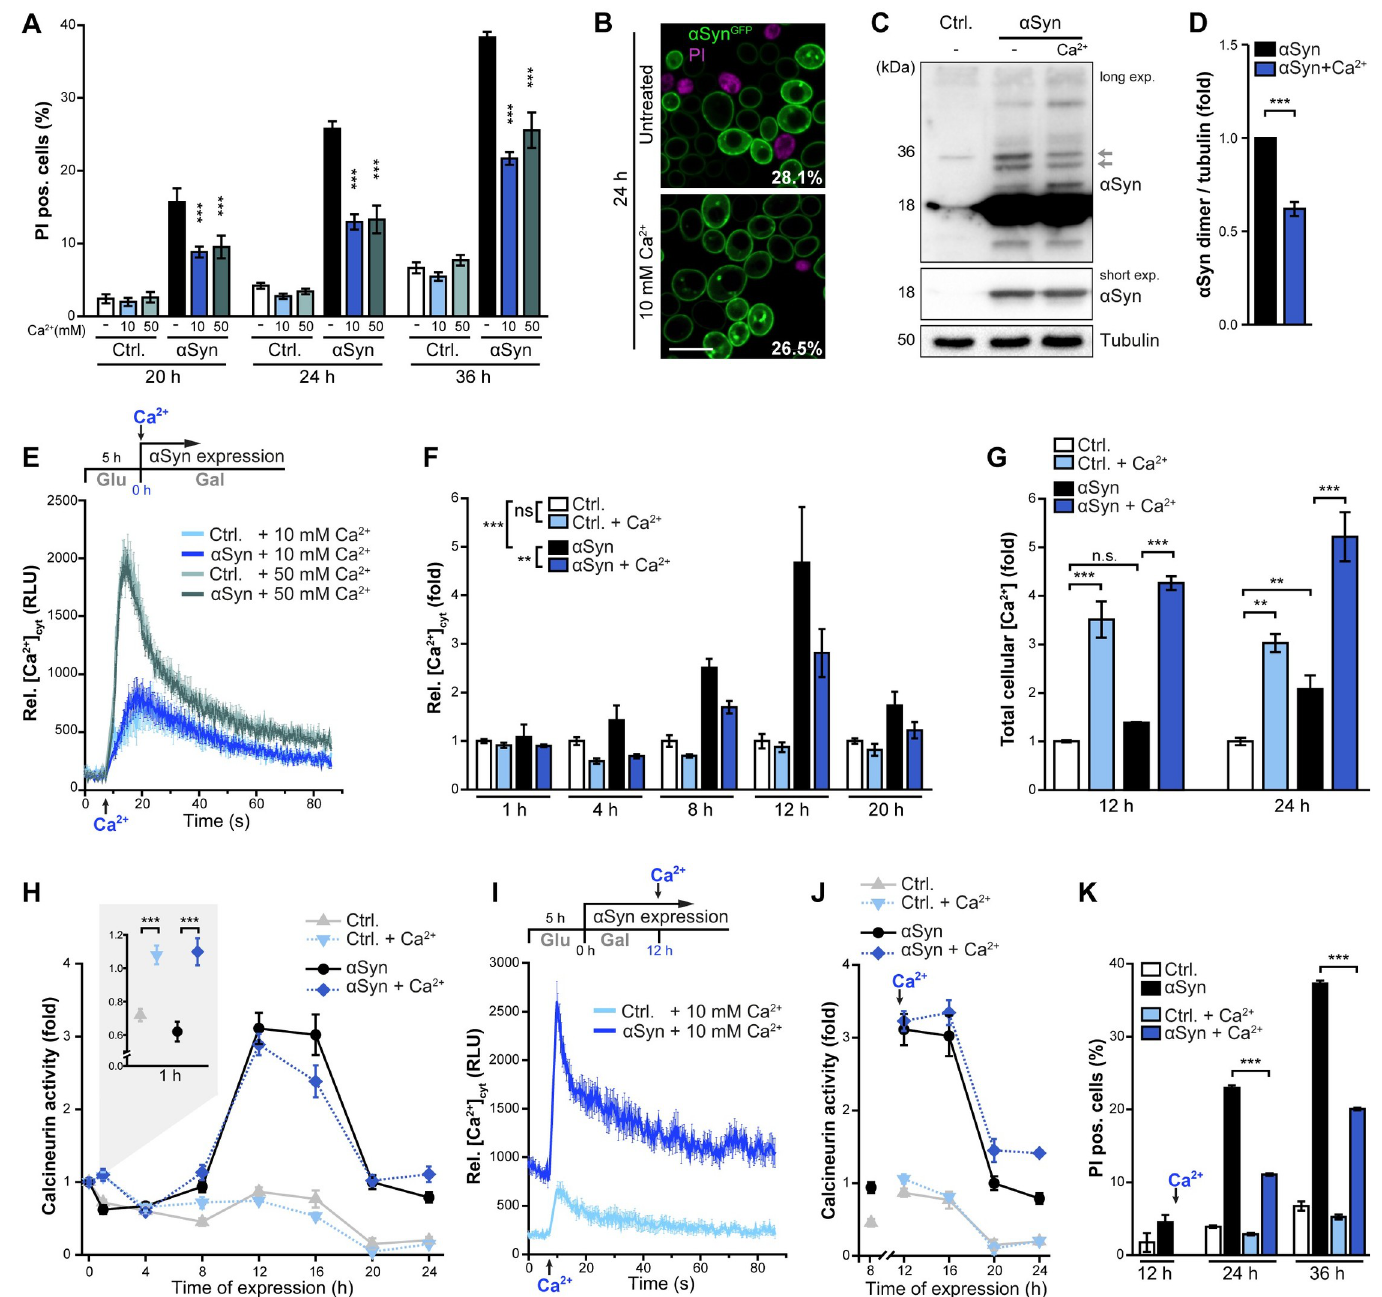
Fig 2. An external Ca 2+ pulse enforces organellar ion storage and mitigates the α Syn-driven rise in cytosolic Ca 2+ . ( A ) Flow cytometric quantification of cell death via propidium iodide (PI) staining of cells expressing α Syn for indicated time points or harboring the vector control (Ctrl.). Cells were supplemented with additional 10 mM and 50 mM CaCl 2 at the time point of shift to galactose or left untreated. Means ± s.e.m; n = 8. ( B ) Confocal micrographs of cells expressing α Syn GFP for 24 h counterstained with PI to visualize dead cells. Cells were supplemented or not with 10 mM Ca 2+ at the time point of shift to galactose media. Scale bar represents 5 μ m. Values indicate mean percentages of cells with α Syn GFP aggregates, with the following s.e.m.: Untreated : 28.1% ± 1.5% (in total 395 cells were evaluated); 10 mM Ca 2+ : 26.5% ± 1.8% (in total 643 cells were evaluated); n > 4. ( C-D ) Representative semi-native immunoblots of protein extracts of cells grown on media with and without additional 10 mM Ca 2+ for 36 h (C) and corresponding densitometric quantification (D) of dimeric α Syn species (as indicated by arrows in (C)). Blots were probed with antibodies directed against α Syn and tubulin as loading control, and the combined signal of the dimeric α Syn species was normalized to tubulin. Means ± s.e.m; n = 10. ( E ) Measurement of cytosolic Ca 2+ levels in cells equipped with a luminescence-based aequorin reporter construct. After monitoring the basal cytosolic Ca 2+ levels, Ca 2+ was automatically injected to the indicated final concentrations to assess the rapid cellular response to the external Ca 2+ addition. As measurements were performed at the time point of shift to galactose media, corresponding to the Ca 2+ addition setup described in (A-D), α Syn is not yet expressed. Means ± s.e.m; n = 6. ( F ) Measurement of